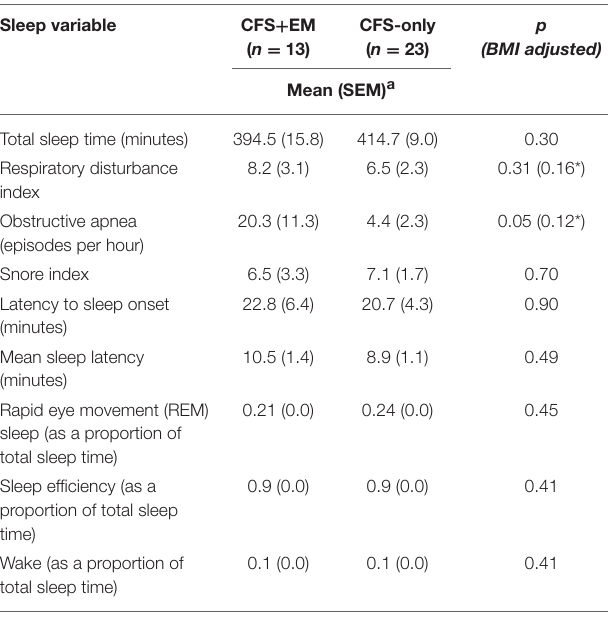
TABLE 5 | Sleep characteristics of the women with chronic fatigue syndrome, by subgroup—with and without